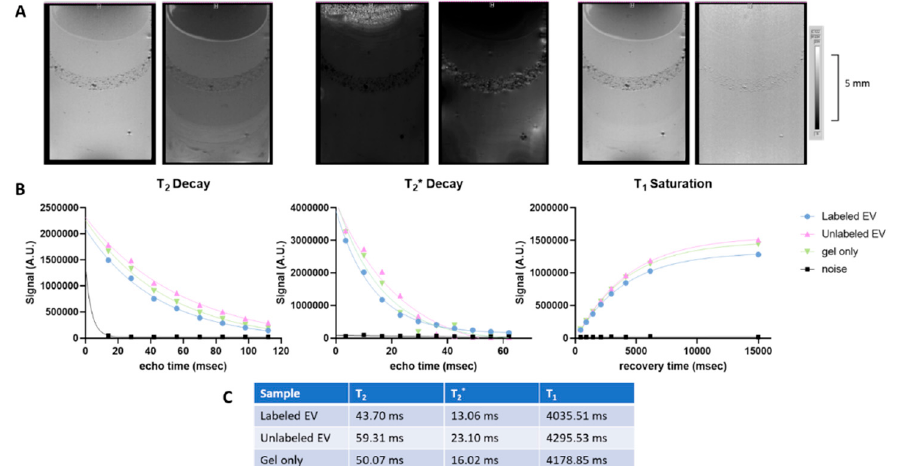
Figure 5. In vitro MRI for labeled brain organoid − EVs (15–20 nm) with a revised gel preparation method. ( A ) MR images demonstrated punctuated contrast in the labeled EVs layer compared to un- labeled EV. ( B ) T 2 (left) and T 2* (middle) decay rates as well as T 1 saturation (right) are demonstrated for labeled and unlabeled EV compared to gel only. ( C ) T 2 , T 2* , and T 1 values were extracted from their respective